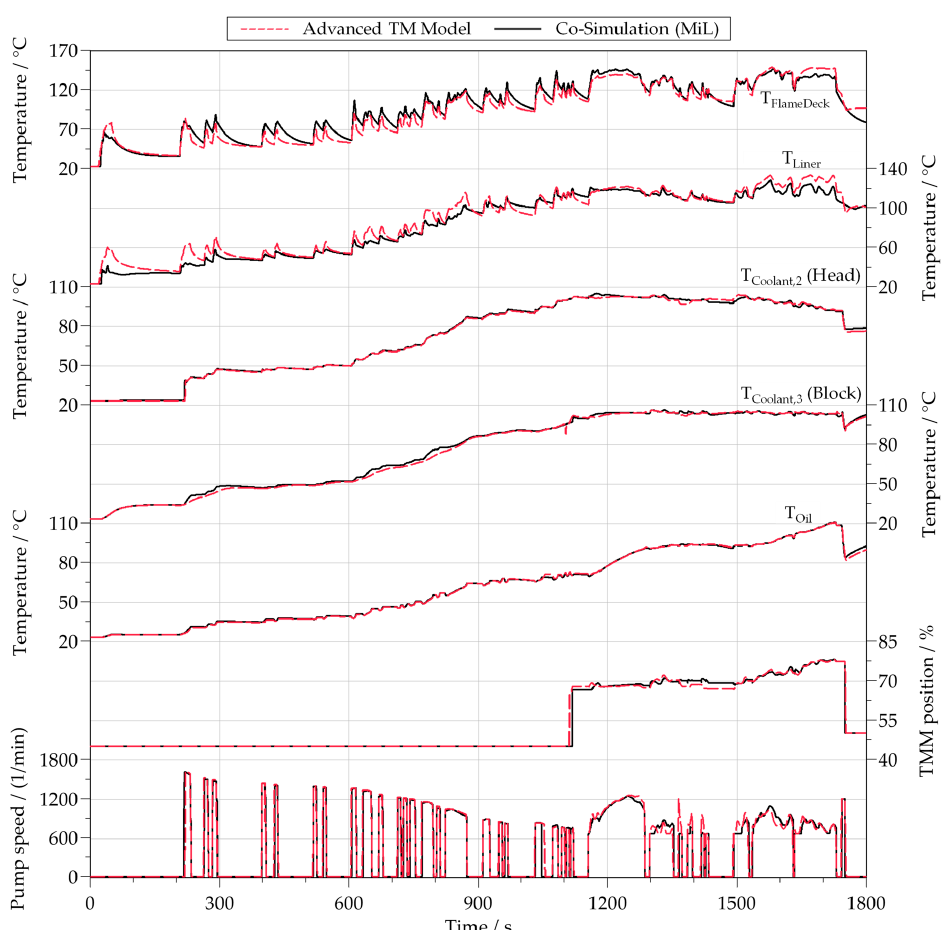
Figure 12. WLTC simulation results of ATMM and Co-simulation (MiL) at 23 °C ambient temperature.